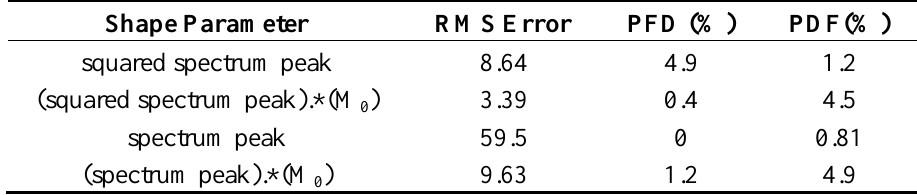
Table 6. Accuracy results of interfacial detection with transducer obstructed by a metallic